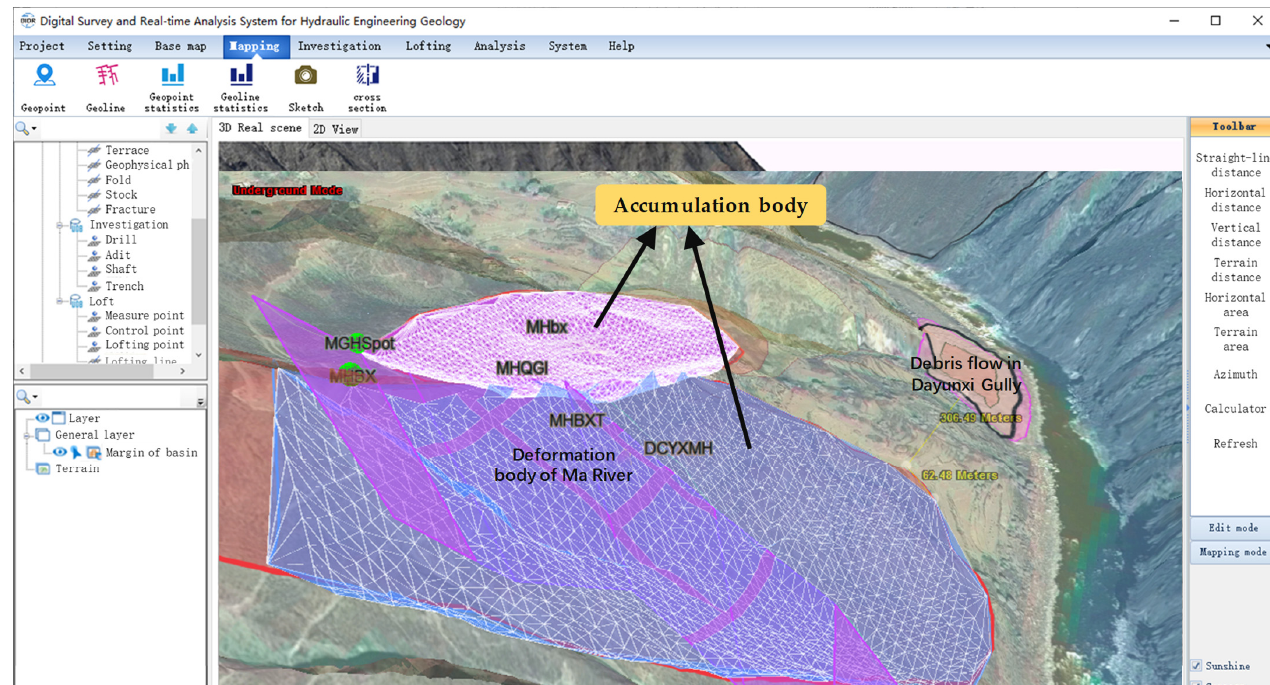
Figure 15. Results of a geological survey.